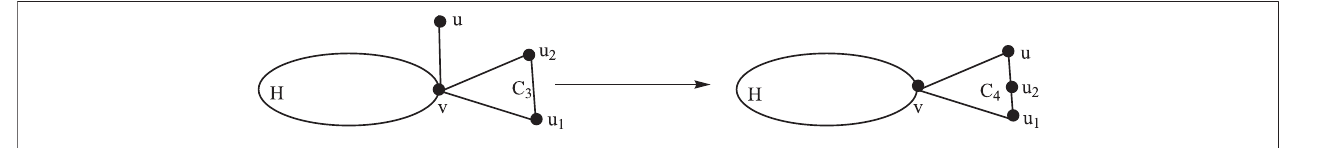
FIGURE 5 | Graphs G 1 . and G 2 of Lemma